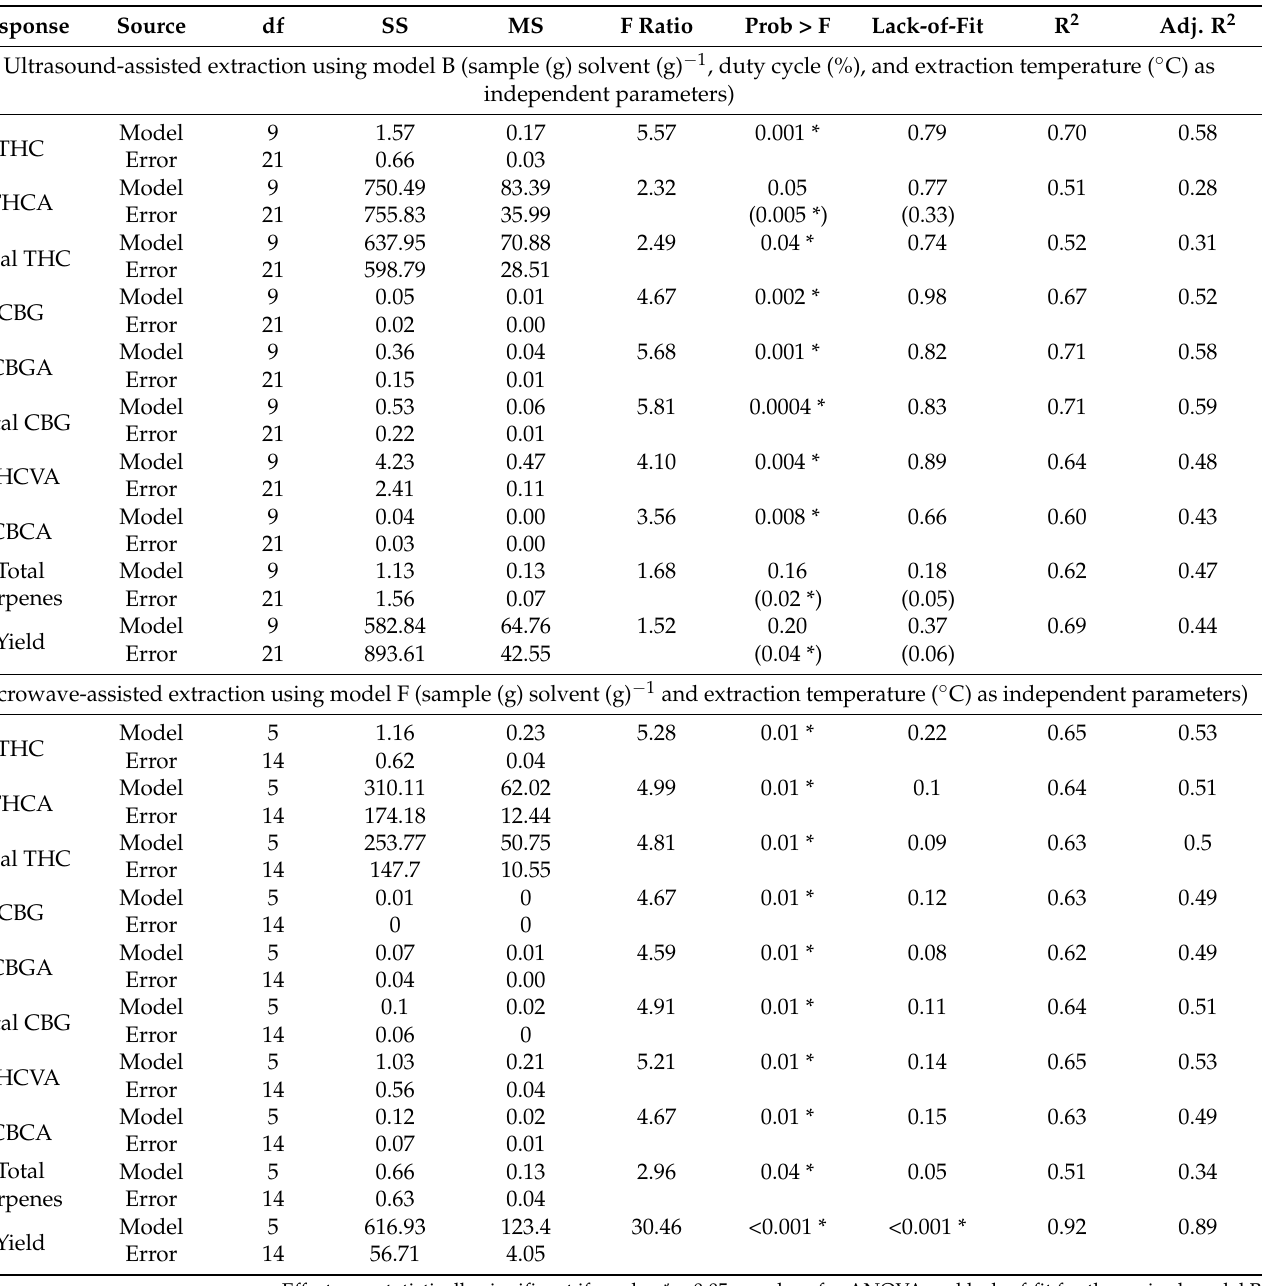
Table 6. Analysis of variance (ANOVA) of responses for ultrasound- assisted and microwave-assisted